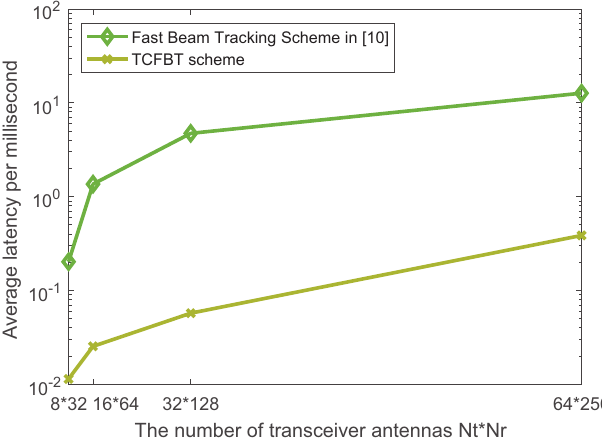
Figure 12. The average latency vs. different antenna numbers.